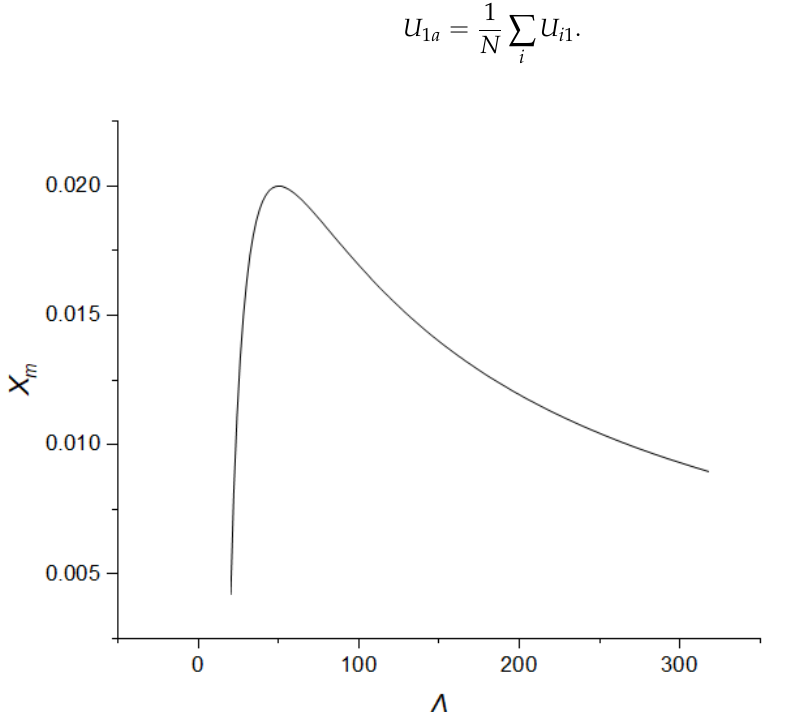
Figure 3. Penetration depth of particles X m as a function of dimensionless filtration coefficient Λ for a layer.